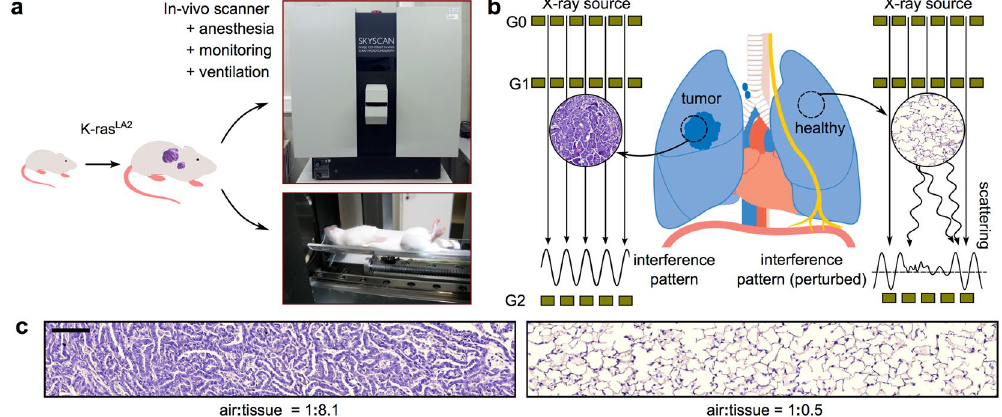
Figure 1. Study design and background of in-vivo small-animal dark-field imaging of lung cancer. ( a ) As a disease model, K-ras LA2 mice were used. These mice frequently exhibit high-grade adenocarcinomas, developing from early onset lung adenomas. In-vivo dark-field imaging was performed using the Skyscan small-animal scanner, which is based on a Talbot-Lau interferometer. ( b ) X-ray dark-field imaging is highly sensitive to distortions of the natural lung micro-anatomy, as indicated using typical histopathology images: a pronounced air-tissue interface in healthy lung tissue (right) causes heavy X-ray scattering. In cancerous tissue (left) the air:tissue volume ratio is reduced due to uncontrolled cell proliferation and loss of alveolar space and therefore X-ray scattering is strongly reduced. Subsequently, information on the scatter properties of the lung can be retrieved by evaluating a setup-specific interference pattern. ( c ) Magnified histological sections visualise the impact of cancer on tissue density and a change in air:tissue distribution, respectively. The scale bar corresponds to 100 μ m. This figure contains a lung illustration adapted from https://commons.wikimedia. org/wiki/File:Diagram_1_of_3_showing_stage_3A_lung_cancer_CRUK_008.svg, which is licensed under the Attribution-ShareAlike 4.0 International license (http://creativecommons.org/licenses/by-sa/4.0/). Further a mouse sketch is adapted from https://commons.wikimedia.org/wiki/File:Knockout_mouse_breeding_scheme. svg, which licensed under the Attribution 3.0 Unported license (http://creativecommons.org/licenses/by/3.0/). Both licenses allow adaptation of images, even commercially.